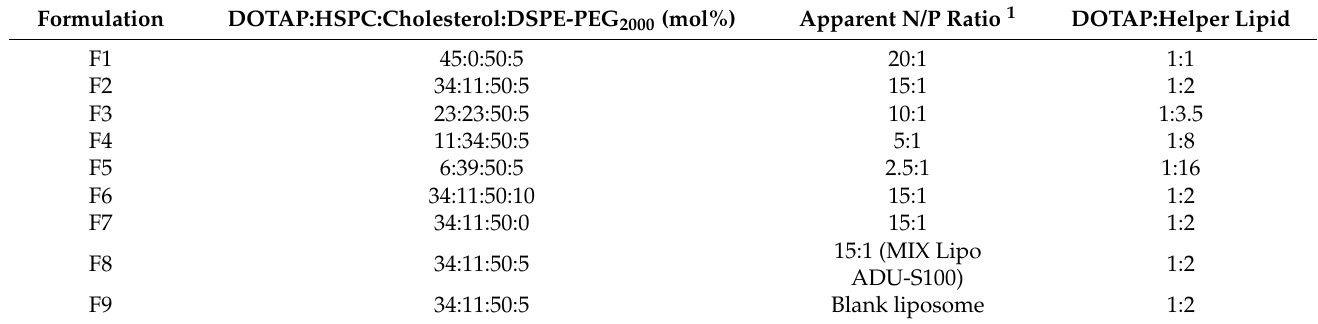
Table 1. Liposomal ADU-S100 formulations with varying lipid compositions and N/P ratios.